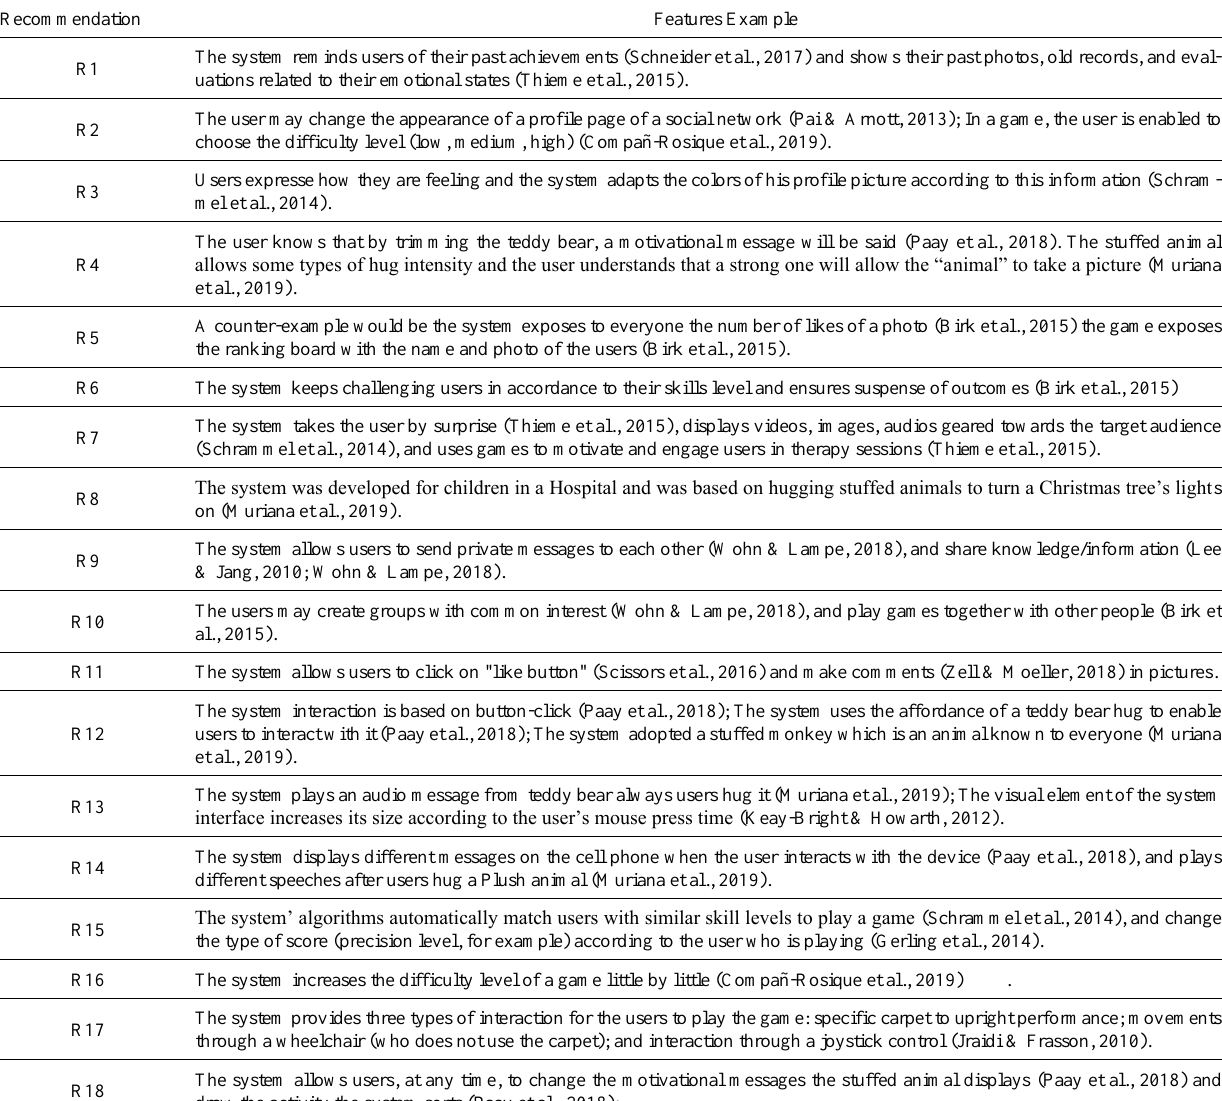
Table 2. Design Recommendations and Systems' features